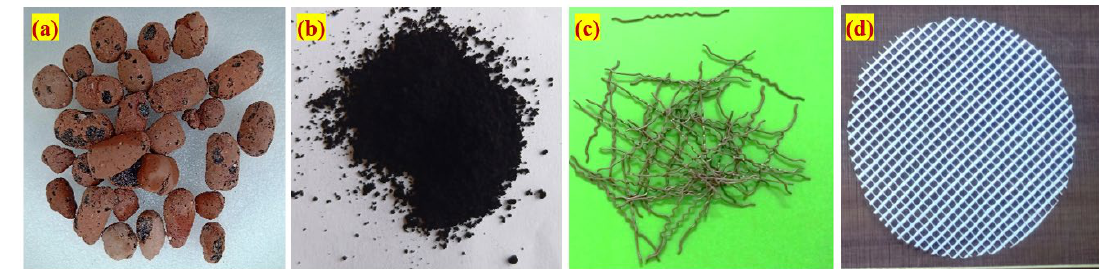
Figure 1. Materials used in this research: ( a ) Expanded clay aggregate; ( b ) Multi-walled carbon nanotube; ( c ) Steel fibre; ( d ) Glass fibre mesh of 150 mm diameter.